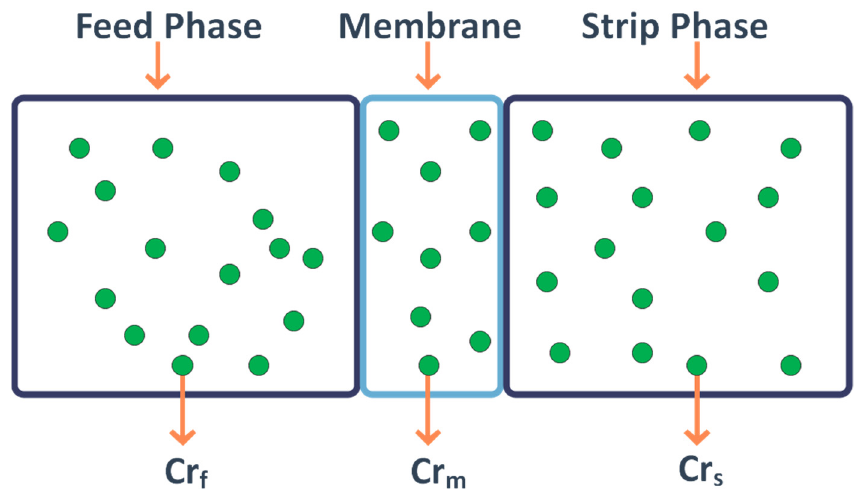
Figure 4. Mass transfer of chromium (III) ions in SLM.